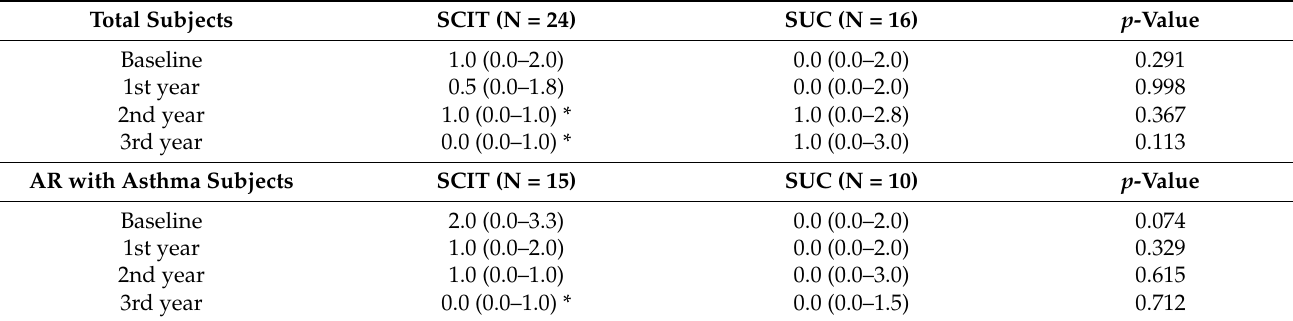
Table 5. Upper respiratory tract infection (URTI) (time/year) requiring antibiotics before and after treatment between the SCIT group and SUC group in AR subjects with or without